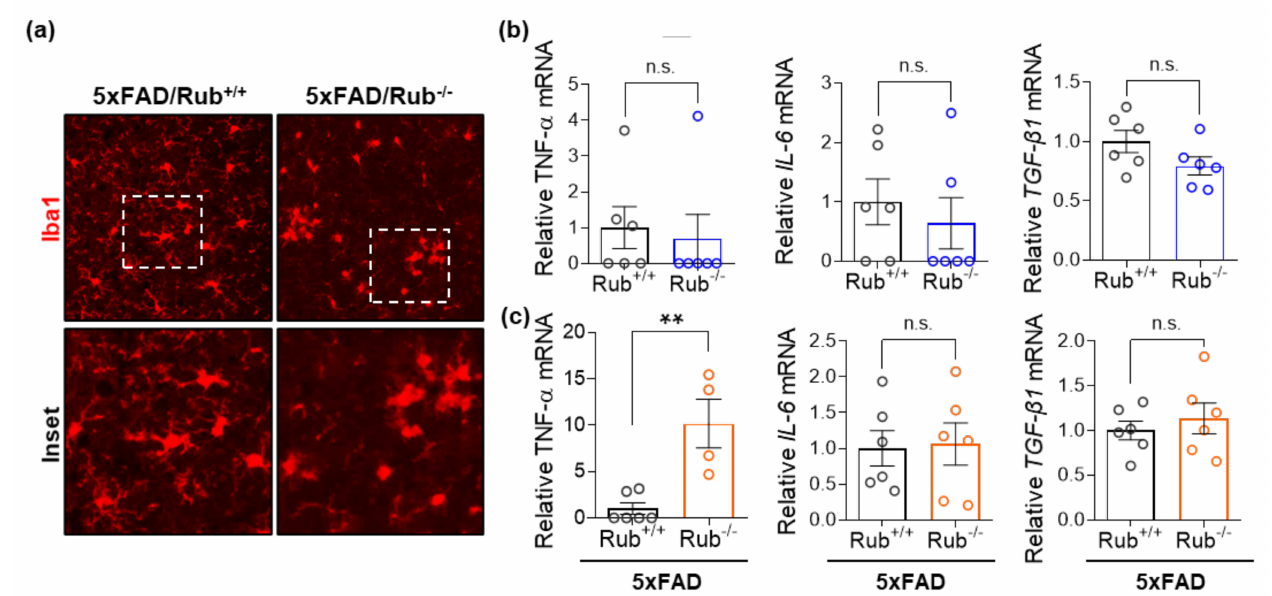
Figure 7. Microglial cells in the cortex from 5xFAD mice lacking Rubicon are more activated. ( a ) Representative Z-stack of confocal images of immunocytochemistry for the detection of microglia (Iba1, red) in the cortex and a zoom of the image (white square, inset) were obtained from 5xFAD mice with and without expression of Rubicon (5xFAD/Rub+/+; 5xFAD/Rub − / − ). ( b , c ) Transcript expression of cytokines TNF- α , IL-6, and TGF- β 1 was measured in samples from the hippocampus ( b ) and brain cortex and ( c ) of 5xFAD/Rub+/+ and 5xFAD/Rub − / − mice at six months of age. Data are mean ± SEM. ** p < 0.01 as determined by the Mann-Whitney t -test, n.s., no